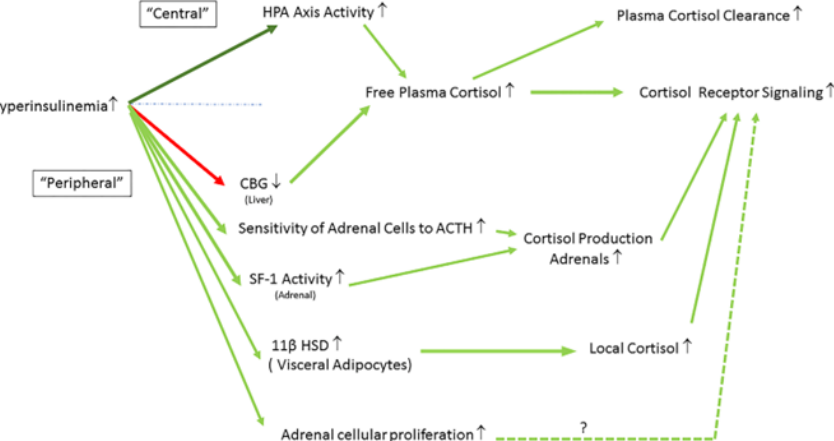
Figure 5. Hyperinsulinemia influences many aspects of cortisol metabolism at both the central and the peripheral level. Interactions are shown between hyperinsulinemia, HPA axis activity, 11 β -HSD, sensitivity of adrenals to ACTH, SF-I activity (adrenals), CBG (liver), and adrenal cellular proliferation (See text for more details). Stimulatory effects are shown in green (dark green: central effects; light green: peripheral effects) and inhibitory effects are shown in red. ↑ = increased; ↓ = decreased. List of abbreviations. HPA = hypothalamus-pituitary-adrenal axis activity; CBG = cortisol binding globulin; ACTH = adrenocorticotropic hormone; SF-1 = steroidogenic factor 1; 11 β HSD = 11 beta-hydroxysteroid